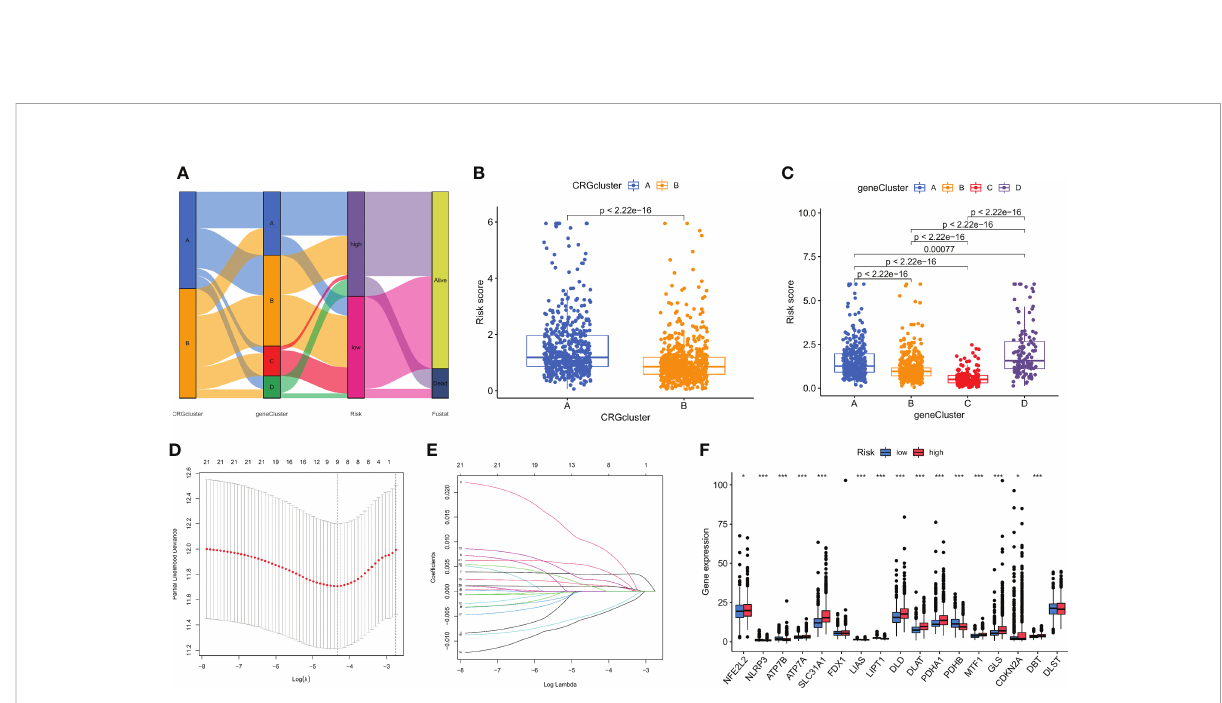
FIGURE 5 The CRG score was created in the TCGA and GSE61304 cohorts. (A) The subtype distributions among groups, CRG scores and survival outcomes. (B) Variations in CRG scores among cuproptosis subtypes. (C) Variations in PRG scores among different gene subtypes. (D) CRG regression using LASSO. (E) Cross-validation of LASSO regression parameter selection. (F) CRG score differences in ten CRGs. *p < 0.05, ***p <